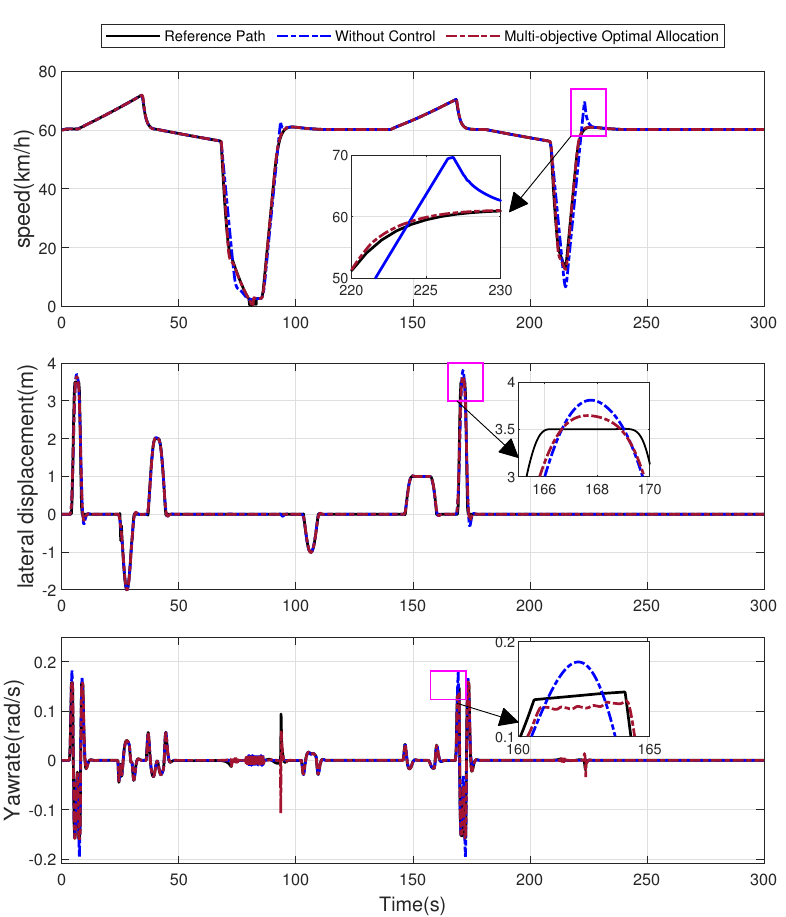
Figure 11. Comparison of results following the proposed multi-objective torque allocation and torque equalization at the lower level. From top to bottom, the figure shows tracking control results for velocity, lateral displacement and yaw